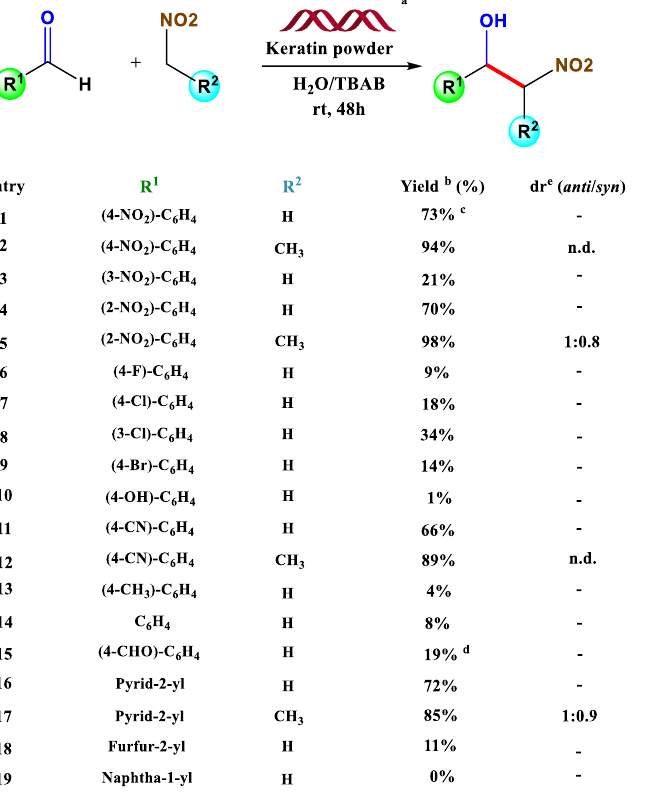
5 of 23 Figure 3. Chemical structure of the dyes. Adapted from Reference [15]. The study compared the activity between wool and activated charcoal, mostly used for adsorption. Four types of wool were used: a fibre sized form, a fine cut one, and